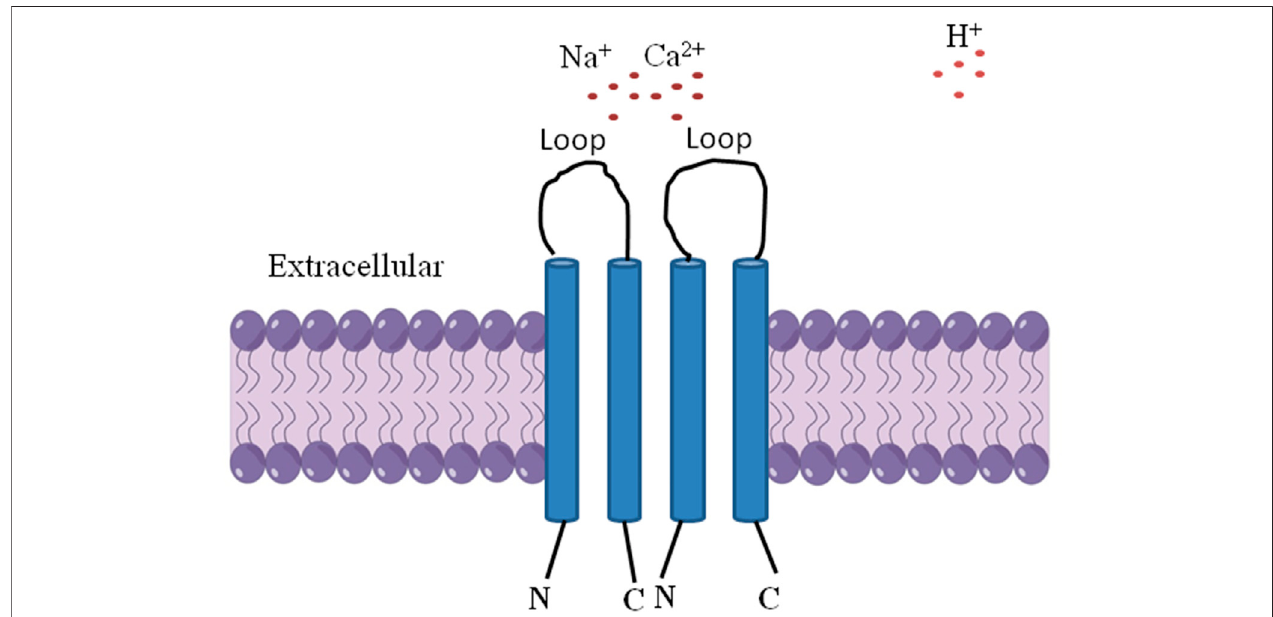
FIGURE1| ThestructureofASIC1aiscomprisedofthreeidentical1asubunits,intracellularaminoterminalandcarboxylterminal,twomembranespaningdomains and an extracellular loop, which can be activated by extracellular H + , open channel has permeability to Na + , Ca 2+ .